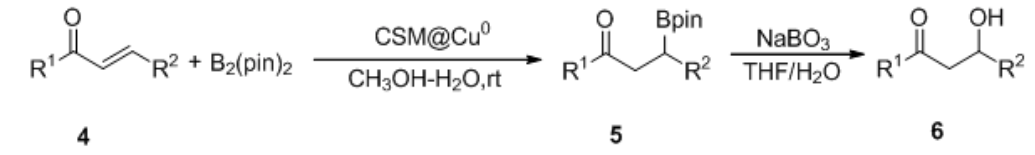
Figure 9. The general route of the boron addition reaction.